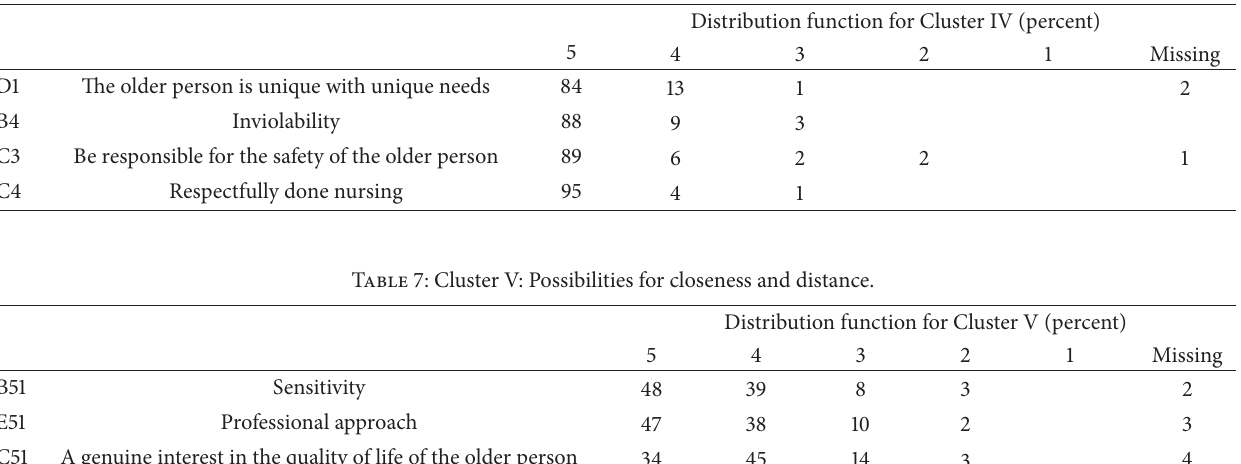
Table 6: Cluster IV: integrity.